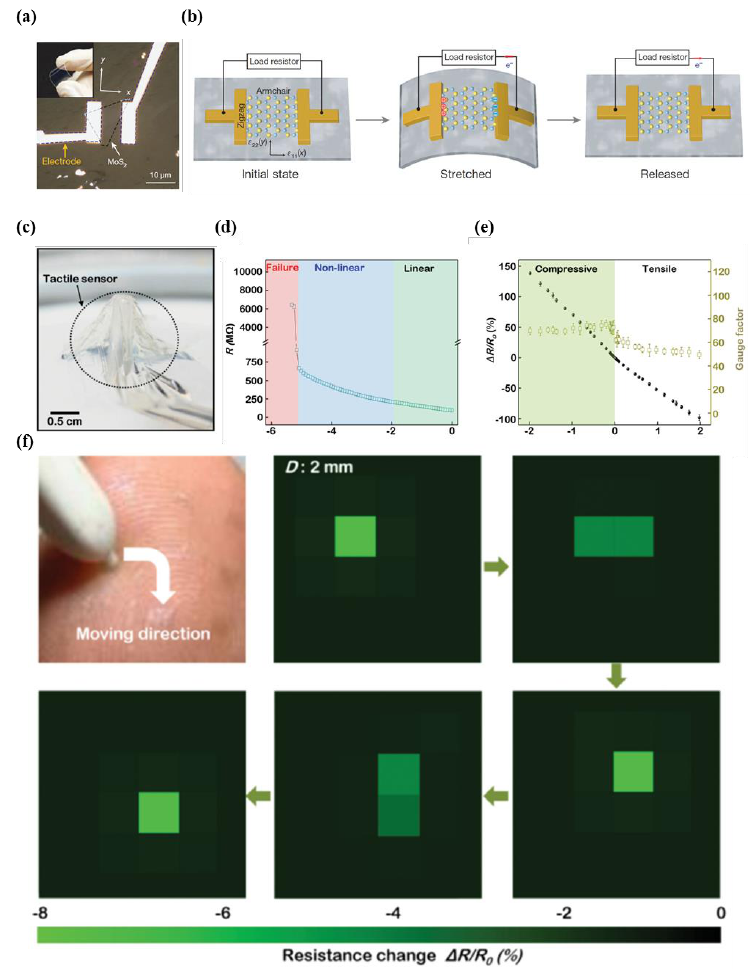
Figure 11. ( a ) Picture and the optical microscopic image of flexible device consisting of single-layer MoS 2 flake; ( b ) schematic illustration of the operating mechanism of single-layer MoS 2 piezoelectric device under strain (reprinted with permission for Figure 11a,b from Ref. [137] Copyright 2014 Springer Nature); ( c ) image of conformal tactile sensor based on MoS 2 floating on the surface of water; ( d ) the output resistance change versus compressive strain; ( e ) fractional change in resistance of the tactile sensor as function of the applied tensile and compressive strain; ( f ) monitoring of pressure distribution (reprinted with permission for Figure 11c–f from Ref. [18] Copyright 2016 John Wiley and Sons).